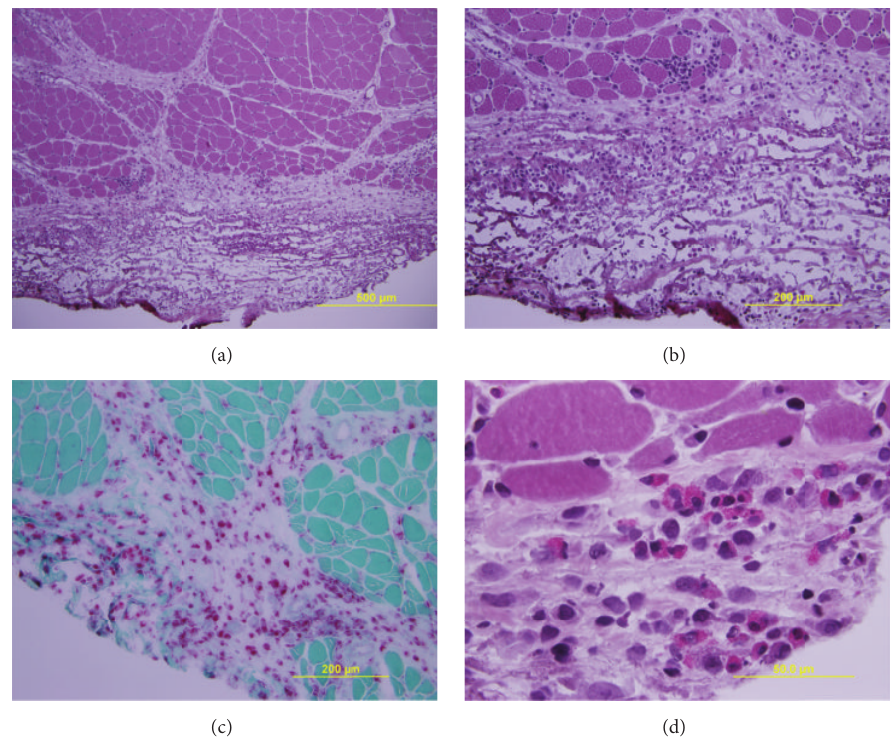
Figure 1: Deltoid muscle biopsy. (a) Low power view showing marked thickening and edema of epimysium and, to lesser extent, perimysium accompanied by diffuse chronic inflammation (H&E stain). There is only minor focal involvement of underlying endomysium. Muscle fascicles are relatively spared. (b) Higher power view of epimysium demonstrating noncohesive chronic inflammation and rarefaction/necrosis of connective tissue (H&E stain). A single necrotic fiber undergoing phagocytosis is observed in the adjacent fascicle. (c) Infiltrates are composed primarily of histiocytes, highlighted as red-staining cells in this preparation (acid phosphatase stain). (d) High power view of more focal collection of eosinophils within the epimysium (H&E